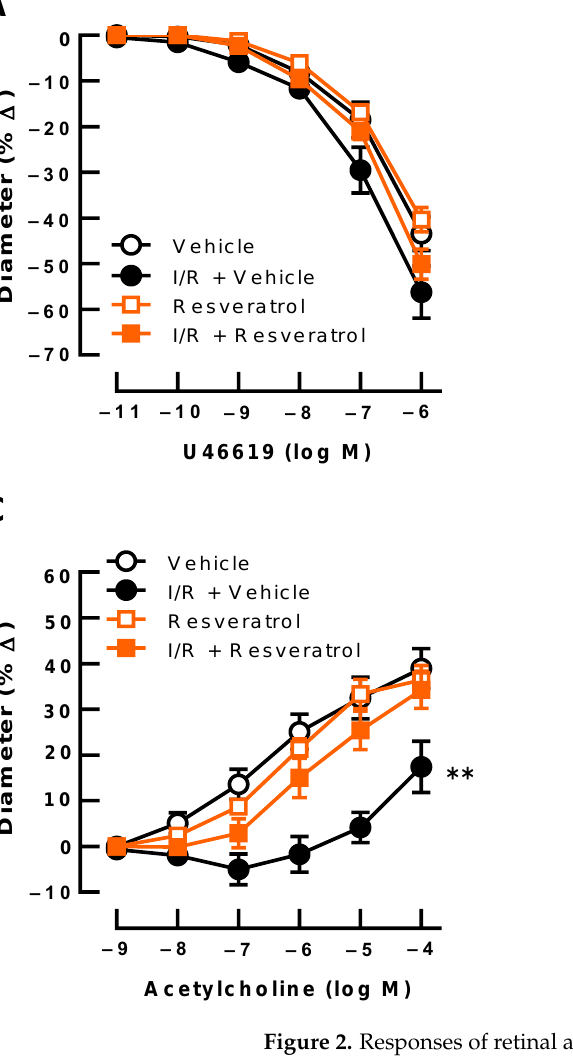
independent vasodilation induced by SNP (10 − 9 –10 − 4 M) was similar in all four groups (Figure 2B). In contrast, acetylcholine-induced (10 − 9 –10 − 4 M) vasodilation was greatly reduced in arterioles from eyes exposed to I/R and vehicle (Figure 2C). Of note, resver- atrol prevented endothelial dysfunction following I/R (Figure 2C). In arterioles from vehicle-treated (controls) and from resveratrol-treated eyes, stepwise increases in perfusion pressure produced pressure-dependent vasoconstriction in the pressure range between 40 mmHg and 80 mmHg, suggesting intact autoregulation (Figure 2D). In contrast, arteri- oles exposed to I/R and vehicle dilated with increasing pressures, indicative of abolished autoregulation (Figure 2D). Remarkably, resveratrol treatment retained pressure-dependent vasoconstriction responses following I/R (Figure 2D).